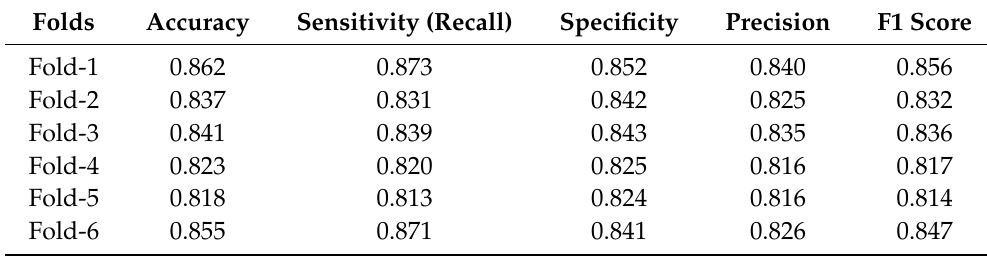
Table 6. The evaluation metrics for plain VGG16.